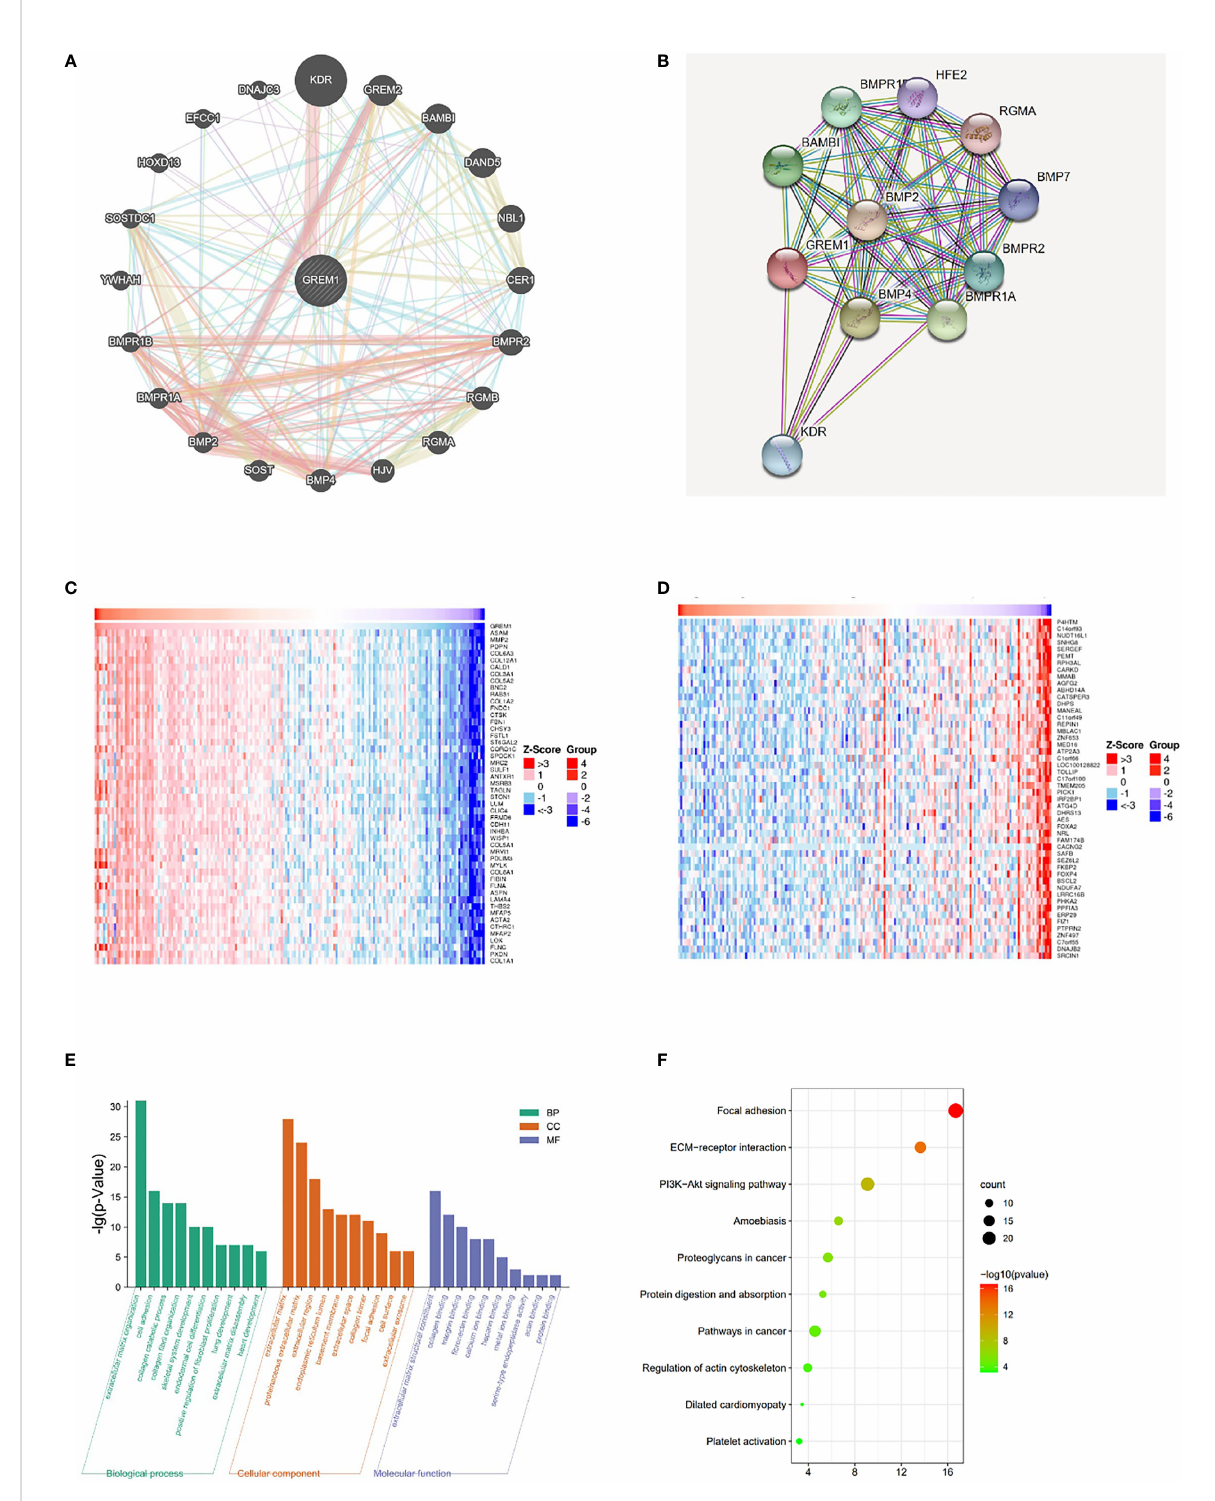
FIGURE 5 Related gene analysis of GREM1 and pathway function prediction in PDAC. (A) The gene – gene interaction network of GREM1 was constructed using GeneMANIA. (B) The PPI network of GREM1 was generated using STRING. (C, D) A heatmap shows the correlations between positively and negatively related signi fi cant genes in PDAC by LinkedOmics (Spearman ’ s correlation). (E) GO and (F) KEGG analyses for GREM1. PDAC, pancreatic ductal adenocarcinoma; PPI, protein – protein interaction; GO, gene ontology; KEGG, Kyoto Encyclopedia of Genes and